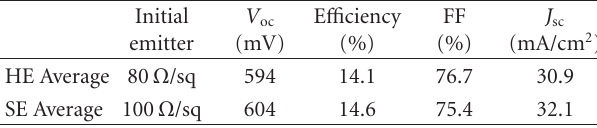
Table 1: Averaged cell parameters from illuminated I - V results (HE stands for homogeneous emitter and SE selective emitter).